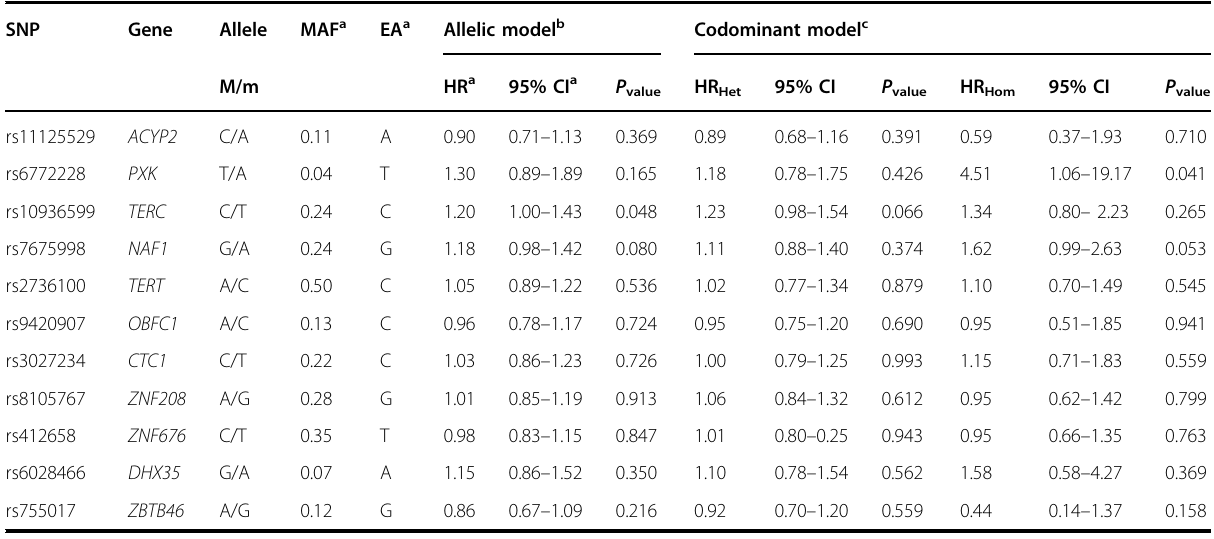
Table 4 Association between individual SNPs and MM OS, adjusted by stage (Durie-Salmon). SNP